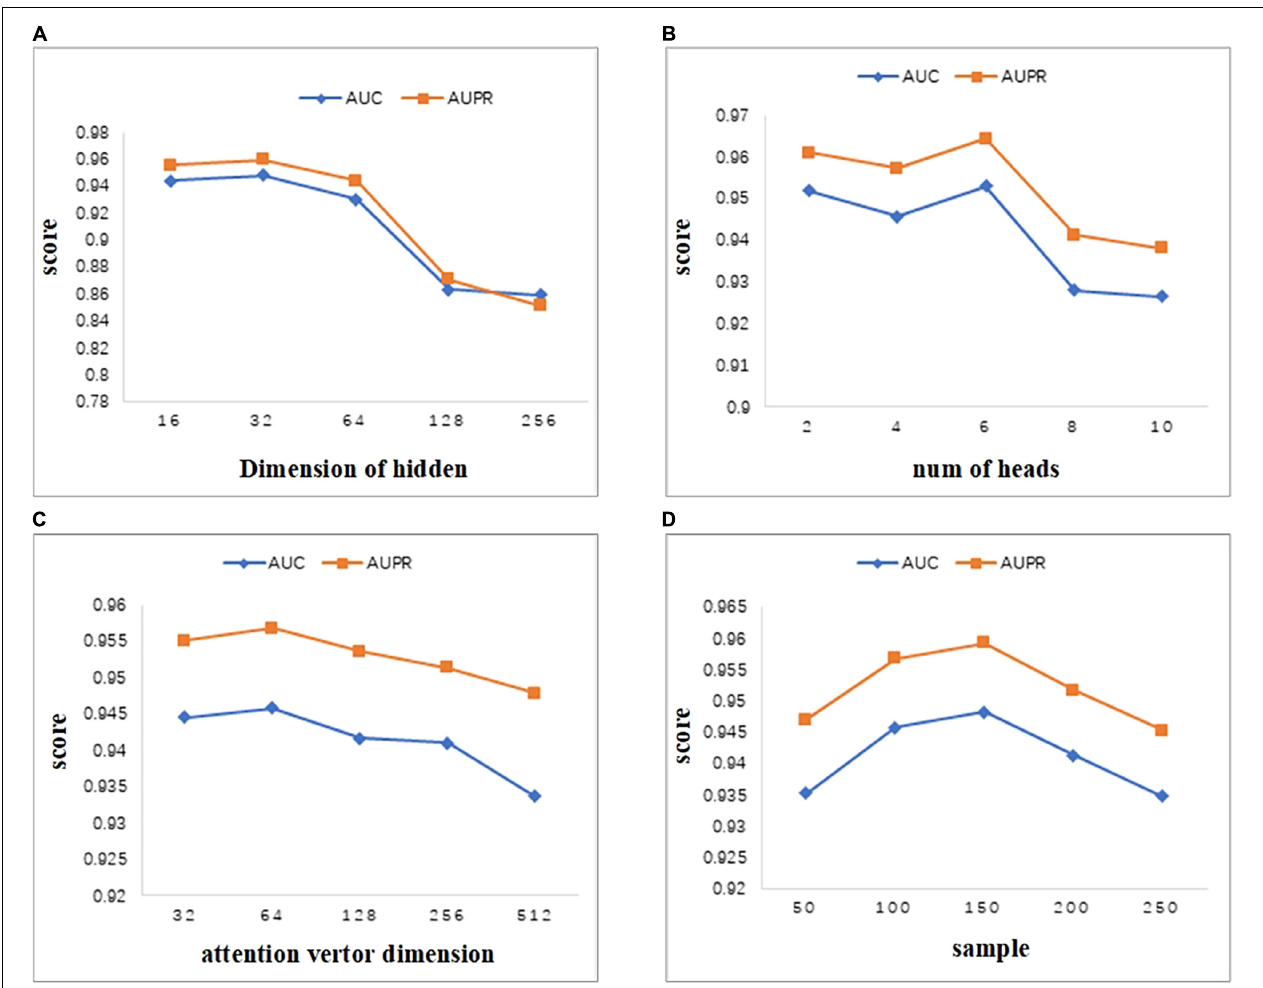
FIGURE 4 | Parameter analysis. (A) Comparison of AUC and AUPR for different hidden layer dimensions. (B) Comparison of AUC and AUPR of attention heads for different multi-attention mechanisms. (C) Comparison of AUC and AUPR for different attention vector dimensions. (D) Comparison of AUC and AUPR for different numbers of neighbors sampled by